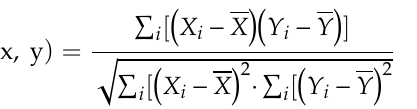
Figure 11. Values of the coefficient of correlation calculated between the flow length and the process fingerprints.